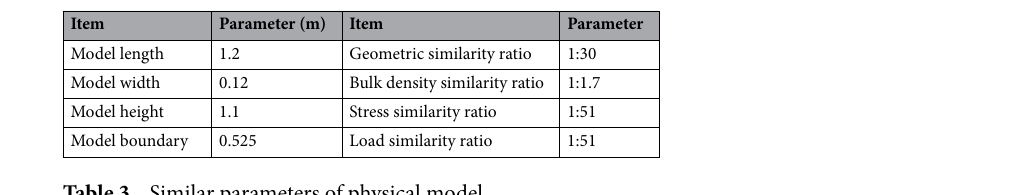
Table 3. Similar parameters of physical model.